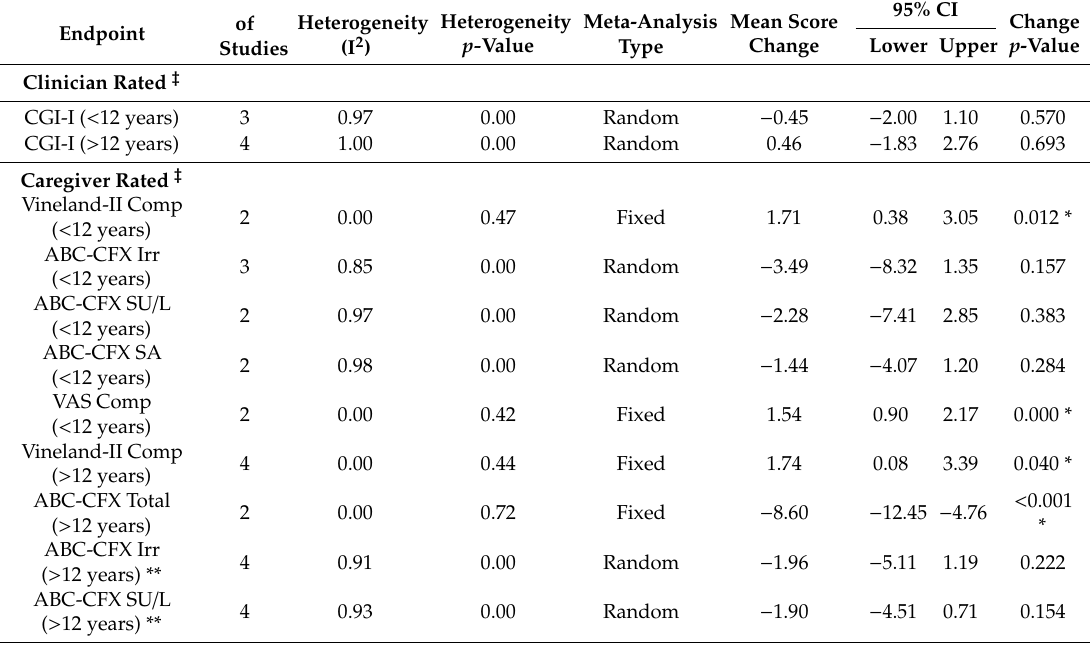
Table 3. Outcome measures changes in placebo-treated groups with FXS in failed clinical trials–Sensitivity